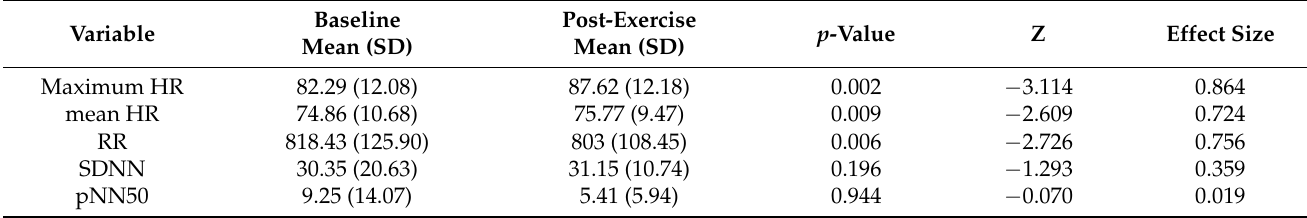
Table 2. HRV at baseline and after exercise in people with